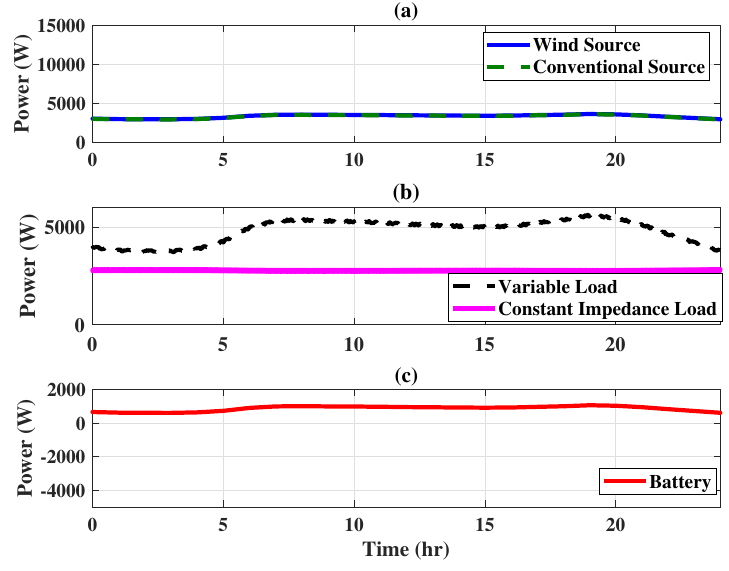
Figure 17. Simulation results using traditional droop control: ( a ) power supplied by each source; ( b ) power consumed by each load; and ( c ) power supplied by the